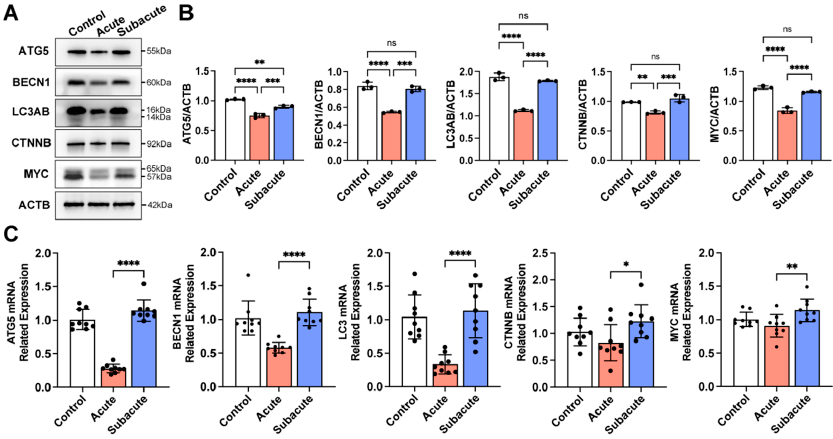
Figure 3. The activation of autophagy flux and the WNT/CTNNB pathway in hNSCs within TBI brain extracts. Markers of autophagy flux (ATG5, BECN1, and LC3AB) and the WNT/CTNNB pathway (CTNNB and MYC) were detected ( A ). Related expression of these proteins and mRNAs indicated that autophagy flux and the WNT/CTNNB pathway were strongly activated in the subacute TBI microenvironment ( B , C ). The black circle in B,C represented the individual value of each sample. *: p < 0.05; **: p < 0.01; ***: p < 0.001; ****: p < 0.0001; ns: p ≥ 0.05. 3.4. Activating Autophagy Rescued the Neuronal Differentiation within Acute TBI Brain